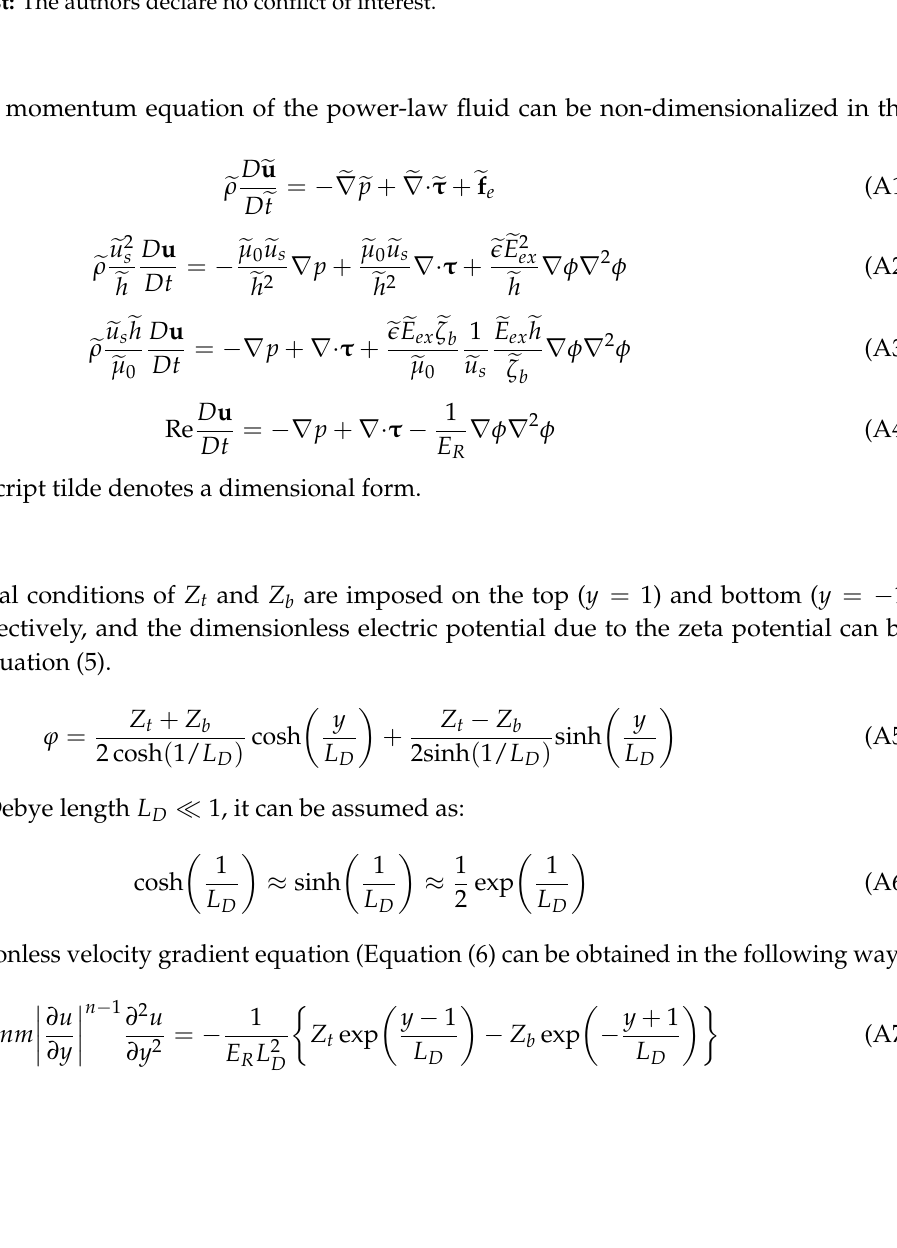
Table S1: Flow rate error (%) between approximate solution and numerical analysis at Z R = 1.5, Table S2: Flow rate error (%) between approximate solution and numerical analysis at Z R =